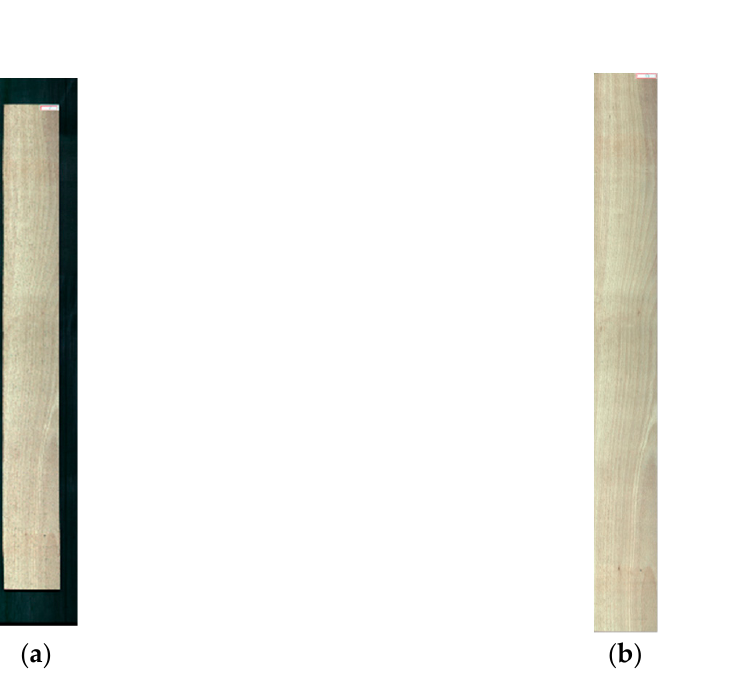
Figure 2. Example of the result: ( a ) original image; ( b ) image with the background removed.